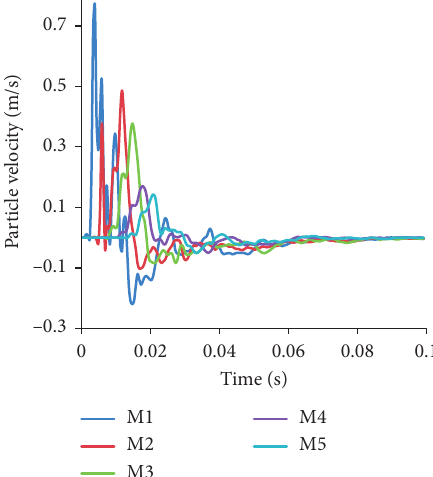
Figure 8: Particle velocity histories at different monitoring